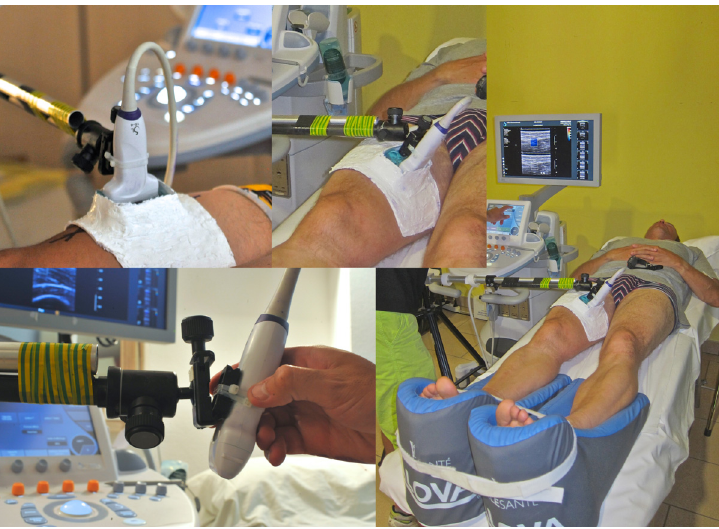
Fig 2. Measurement protocol and subject positioning. An articulated arm ensures that no contact occurs between the transducer and the thigh. Acoustic coupling is ensured using a home-designed silicon pool conforming to the shape of the leg that is filled with bubble-free acoustic gel. All subjects were placed in the supine position using a feet holder to ensure that the quadriceps femoris muscle remained at rest. To maximize inter-day reliability and hasten re-positioning, 4 indelible skin lines were traced during the Pre session (with a waterproof marker). The first line extended across the thigh and was drawn 15 cm above the upper edge of the patella, perpendicular to the patella-ASIS (anterior superior iliac spine) axis. The remaining three lines were drawn parallel to the longitudinal axis of the center of each of the three muscle heads (RF, VM, VL). Per the PLOS ONE policy regarding papers including identifying or potentially identifying, information, each subject was informed of the terms of the PLOS open-access (CC-BY) license and provided permission for the publication of these details under the terms of the